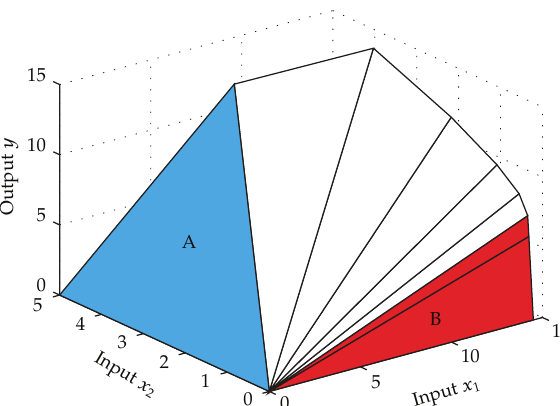
Figure 12: Fully and all weakly e ffi cient triangles.